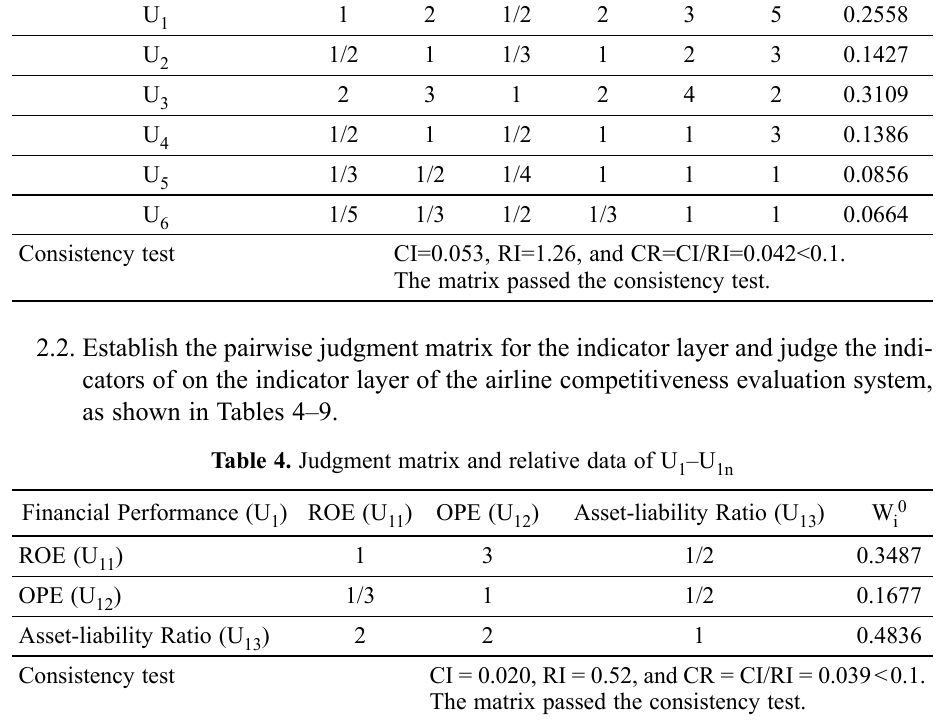
Table 5. Judgment matrix and relative data of U